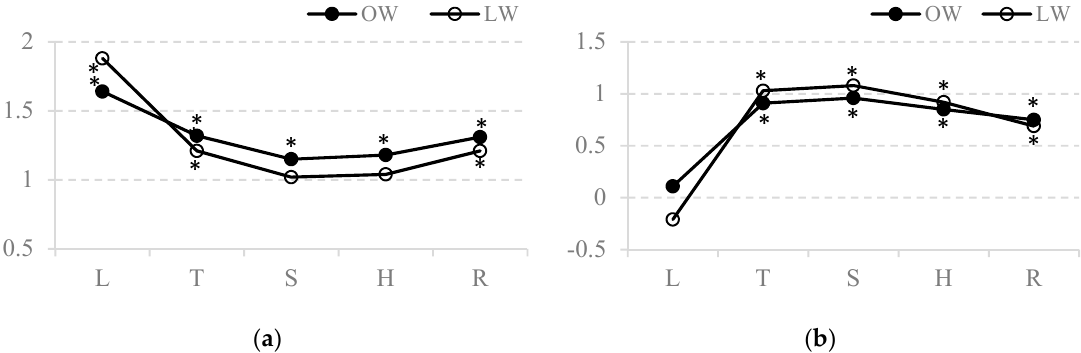
Figure 1. Changes in the RYT ( a ) and Cb ( b ) values for the mixture of barley and rye-grass catch crop during the growth. OW—optimal water supply, LW—water supply reduced 50%; growth stage of barley: L—leaf development, T—tillering, S—stem elongation, H—heading, R—ripening; *—RYT significantly different from 1.0 ( p = 0.05) and Cb significantly different from 0.0 ( p = 0.05).